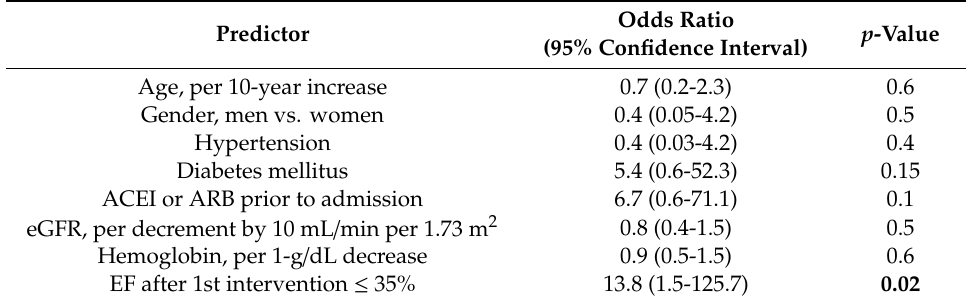
Table 3. Multivariate logistic regression analysis of the predictors of CIN after the 2nd intervention with EF after the 1st angioplasty as a dichotomous variable (EF ≤ 35% vs. EF > 35%).